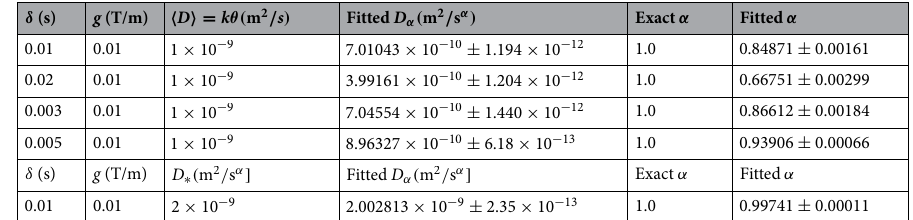
Table 3. Fit parameters of the synthetic curves obtained from SS trajectories obtained using a Gamma 0.5 and a Gaussian distribution with σ D distribution with k =